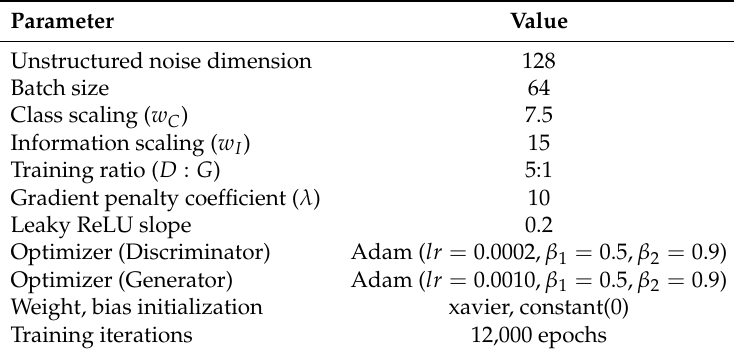
Table A3. WacGAN-info hyperparameters and training settings.